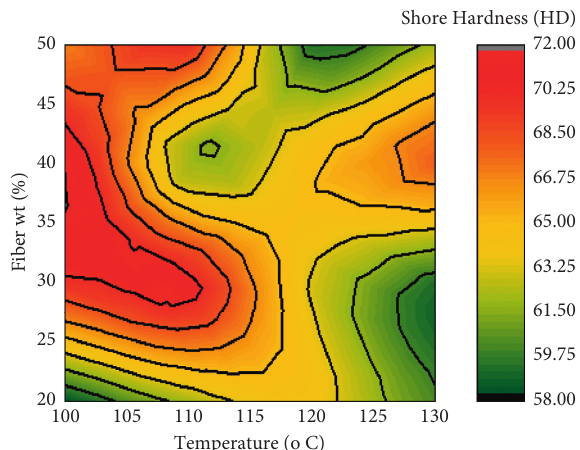
Figure 23: Shore D hardness: contour plot of compression pressure and NaOH action.